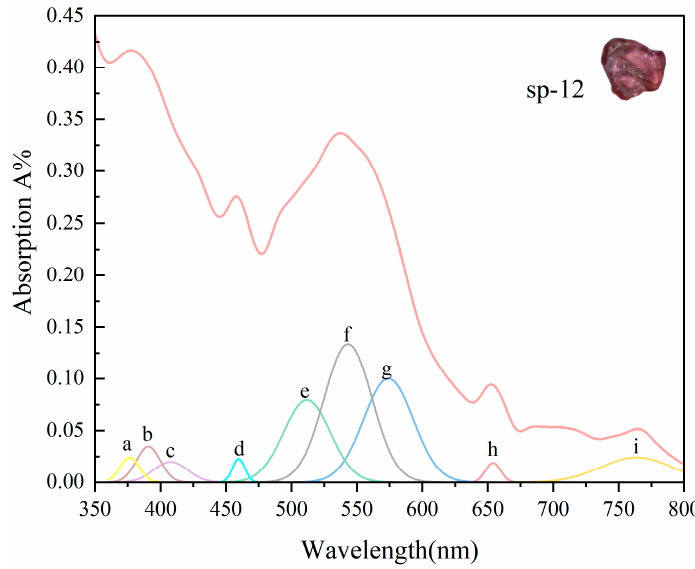
peaks are named from low wavelength to high wavelength from a to g. It is worth noting that it is often difficult to distinguish Cr3+ and V3+ in the split-peak fitting due to the spin-allowed leap at the octahedral position near 405 nm and 530 nm.